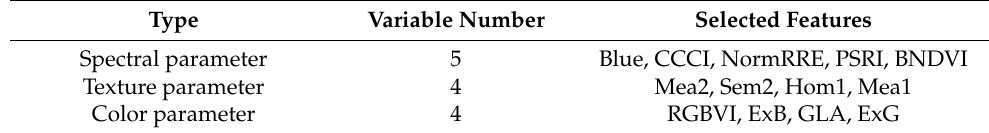
Table 5. Selected spectral, textural and color features.